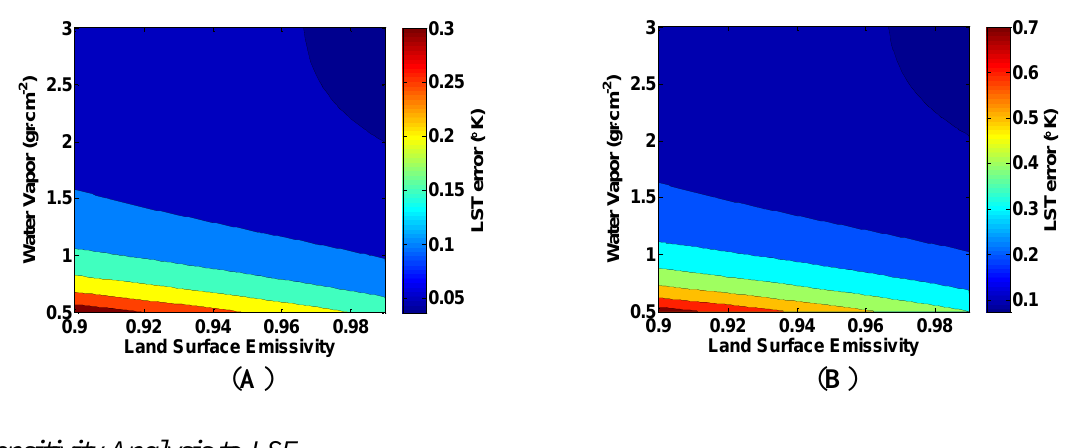
– T is kept constant at 1 °K. 10 11